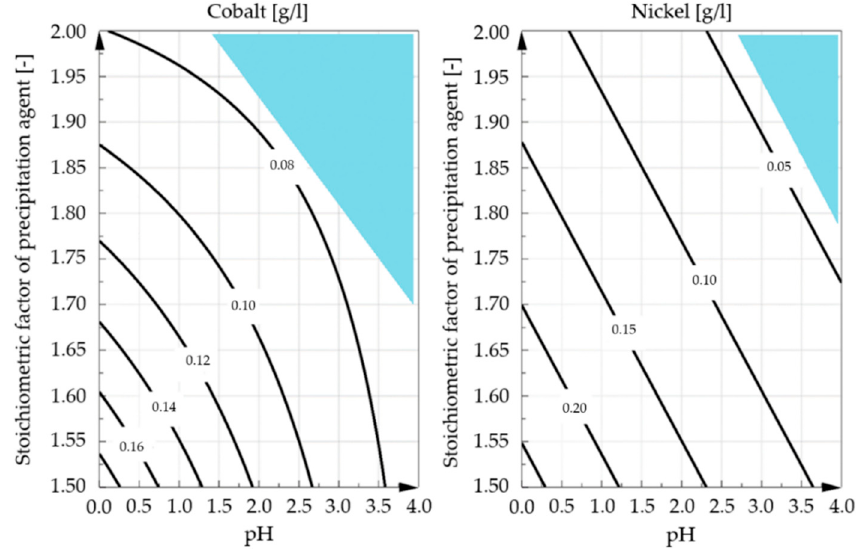
Figure 11. Influence of pH on the residual dissolved concentrations of cobalt and nickel.